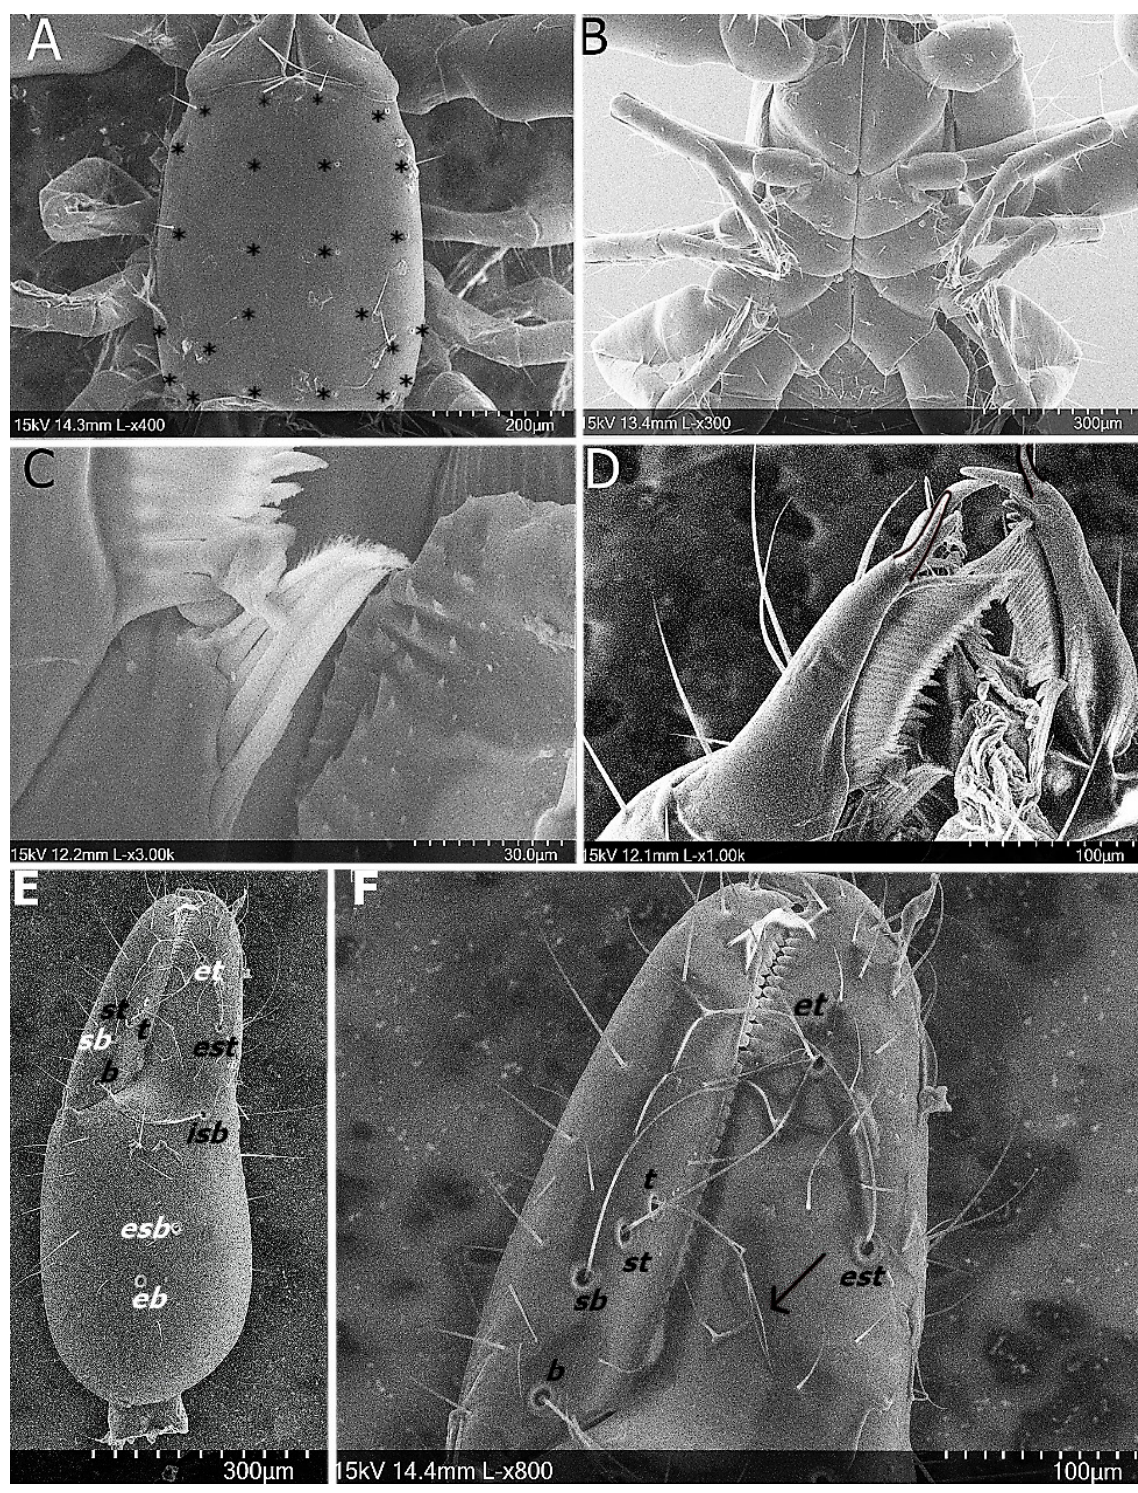
Fig. 5. Scanning electron micrographs of Ideobisium kichwa sp. nov., paratypes. A . Carapace with asterisks next to setae. B . Coxa. C . Rallum. D . Chelicera in ventral view with traced galea. E . Chela in retrolateral view showing trichobothria. F . Close-up view of E showing lanceolate trichobothrium t (arrow). A–B: ♂ (ZMH A0003685); C–D: ♀ (ZMH A0003687); E–F: ♂ (ZMH